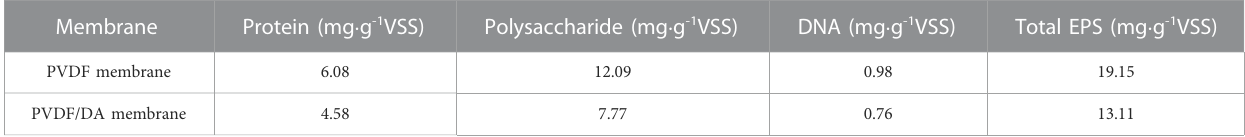
TABLE 5 EPS composition analysis of PVDF membranes and PVDF/DA membranes.